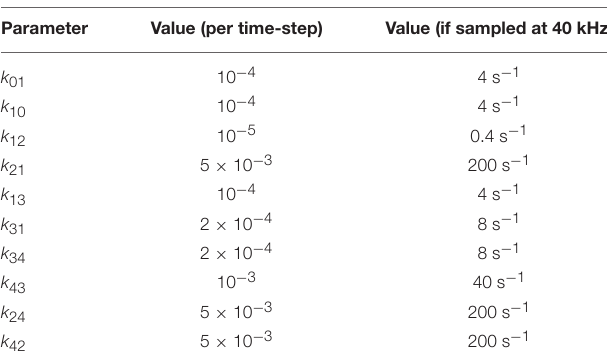
TABLE 1 | Transition kinetics of simulated complex channel used in Figure 5. Parameter Value (per